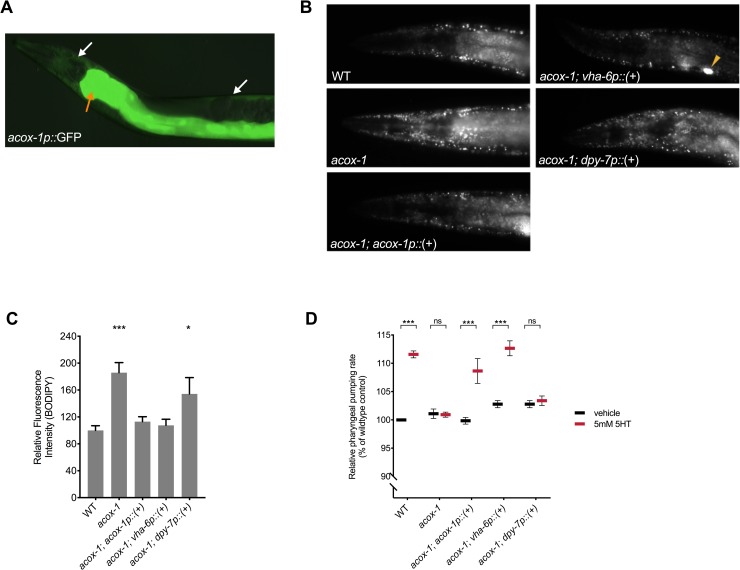
Reconstitution of acox-1 in the intestine rescues fat and feeding phenotypes.(A)
acox-1 is expressed in epidermal (white arrows) and intestinal (orange arrow) tissues. Merged DIC and green epifluorescent image of a transgenic animal expressing an acox-1p::gfp transcriptional reporter. (B and C) Reconstitution of acox-1 gDNA under its own promoter (acox-1p) and under an intestine-specific promoter (vha-6p), but not under an epidermal-specific promoter (dpy-7p), normalizes BODIPY fat levels. Representative images of BODIPY staining (B) and corresponding quantifications (C) expressed as fluorescence intensity relative to wild-type animals. The yellow arrow in (B) indicates a coelomocyte co-injection marker used during transgenic strain generation. Error bars indicate ±SEM from normalized mean, n > 20 per strain. *p < 0.05, ***p < 0.001, ANOVA (Tukey). (D) Reconstitution of acox-1 gDNA under an intestine-specific promoter (vha-6p) restores serotonin responsiveness. Feeding data are normalized to vehicle-treated wild-type animals and are presented as a percentage of wild-type rates. Error bars indicate ±SEM from normalized mean, n > 15 per strain. ***p < 0.001, ANOVA (Tukey). See S1 Table and S1 Data for underlying data. acox-1, acyl-coenzyme A oxidase 1; BODIPY, boron dipyrromethene; DIC, differential interference contrast; gDNA, genomic DNA; ns, not significant; WT, wild-type; 5HT, 5-hydroxytryptamine.